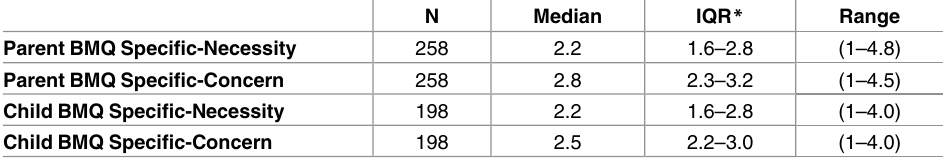
Table 6. Beliefs about medication descriptive